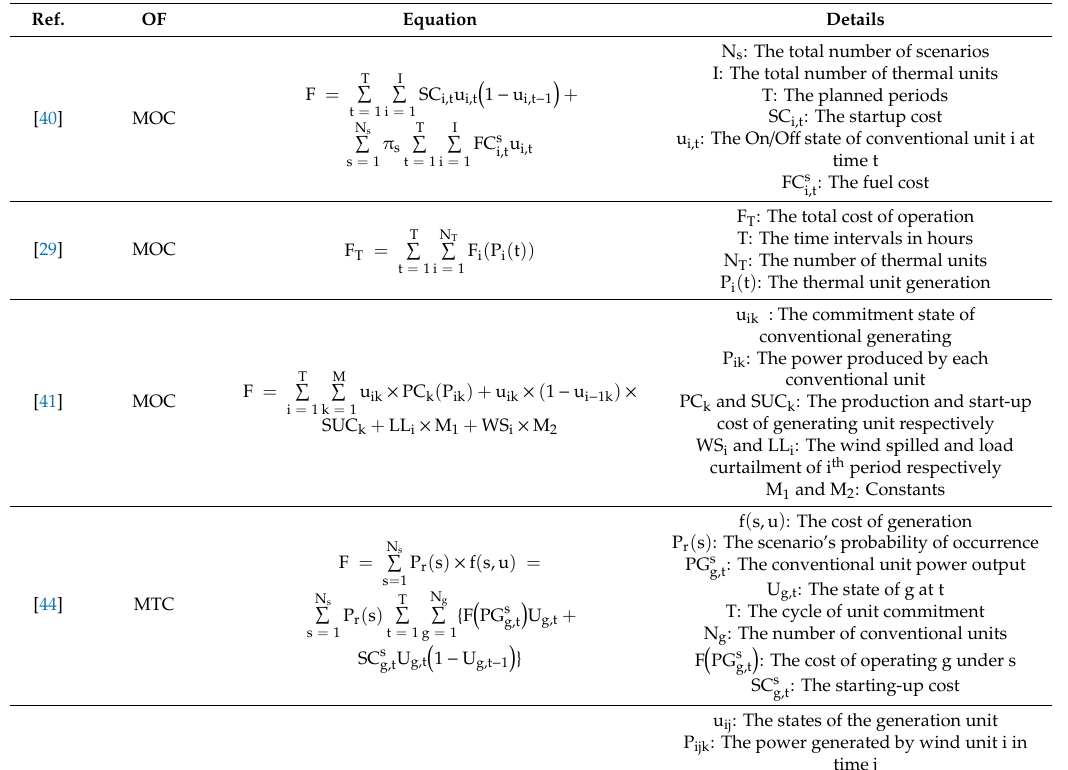
Table 3. Objective functions for the studies that utilize modified particle swarm optimization.